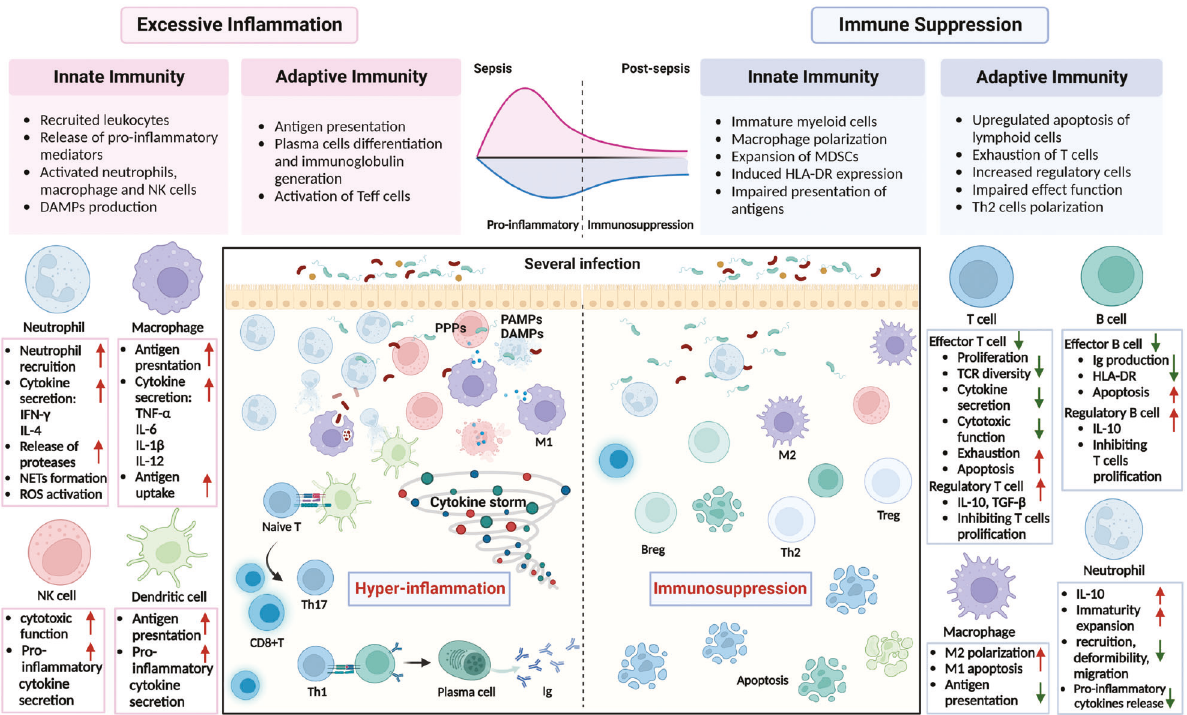
Fig. 1 Hallmarks of the imbalanced immunity in sepsis. Sepsis manifests as an imbalance between in fl ammatory and anti-in fl ammatory responses, with a predominant in fl ammatory response in the early stages, referring to an excessive in fl ammatory state. In contrast, immunity exhibits long-term suppressive features in the late or post-septic stage. After the onset of severe infection, neutrophils are rapidly recruited. They release large amounts of pro-in fl ammatory cytokines, inducing a cytokine storm, and play a role in pathogen clearance. NK cells and macrophages enhance pathogen clearance and release cytokines to exacerbate in fl ammation further. Antigen-presenting cells enhance the ability to present antigens and promote the activation of effector T cells. Plasma cell differentiation is promoted, and the release of immunoglobulins is increased. During the immunosuppressive phase of sepsis, the number of innate and adaptive immune cells is reduced, and apoptosis is induced. Macrophages are polarized toward an anti-in fl ammatory phenotype. Simultaneously, circulating immature neutrophils are increased, and the in fl ammatory function of neutrophils is impaired. In adaptive immunity, the imbalance between effector and regulatory cells promotes immunosuppression, with the proportion and function of regulatory cells enhanced. DAMPs, damage- associated molecular patterns; PAMPs, pathogen-associated molecular patterns; PRRs, pattern recognition receptors; IL, interleukin; NETs, neutrophils extracellular traps; ROS, reactive oxygen species; T, T lymphocytes; B, B lymphocytes; NK, natural killer cells; Tregs, regulatory T lymphocytes; Th, T helper cell; Bregs, regulatory B lymphocytes; Ig, immunoglobulin; TGF β , transforming growth factor- β ; IFN, interferon; TNF, tumor necrosis factor; TCR, Toll-like receptor; HLA-DR, human leukocyte antigen